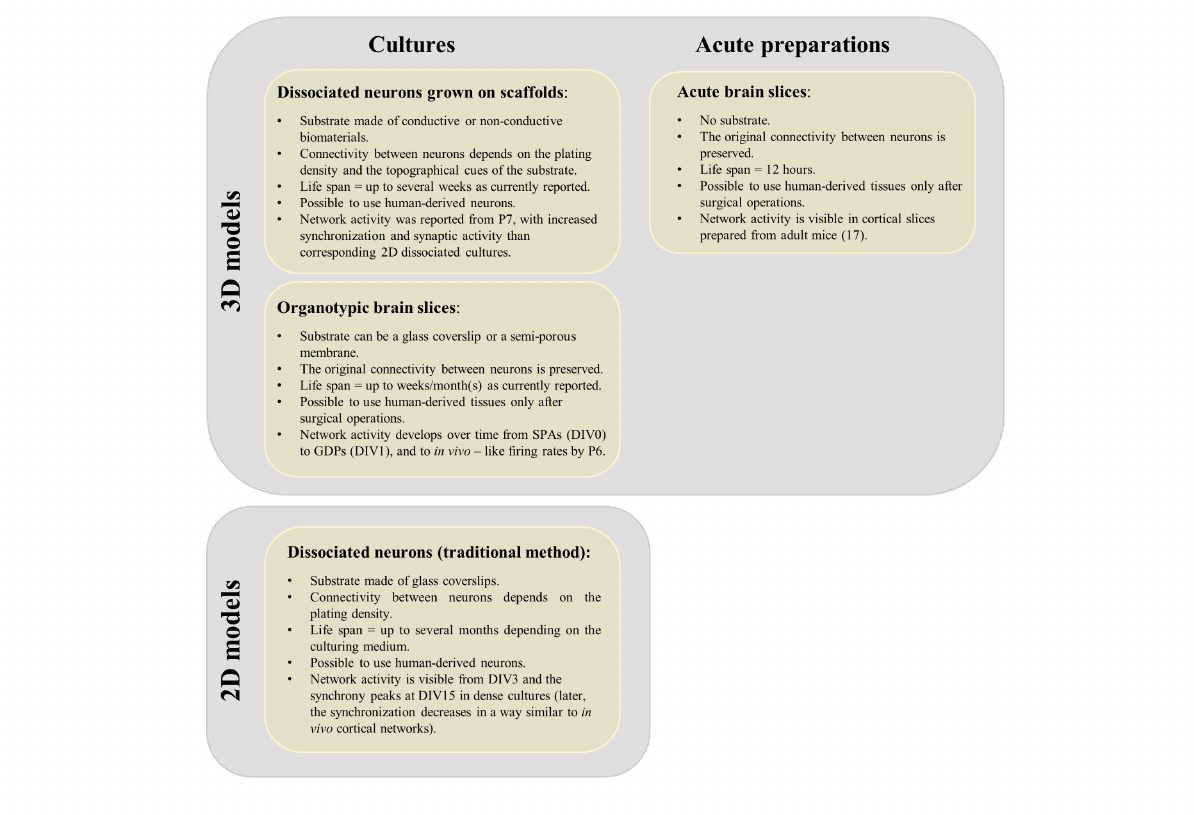
Figure 2. Summary and comparison of in vitro neuronal network models. 3D models include brain slices and dissociated neurons grown on scaffolds. 2D models are represented by dissociated neurons grown on glass (traditional method). The only preparation that does not require culturing is represented by acute brain